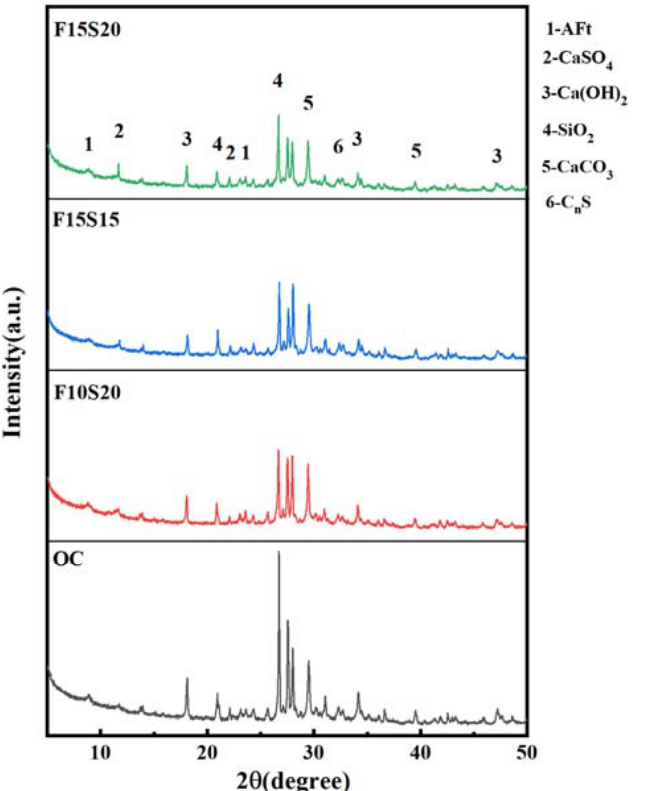
Figure 12. X-ray diffraction pattern of hydration products in concretes at the curing age of 28